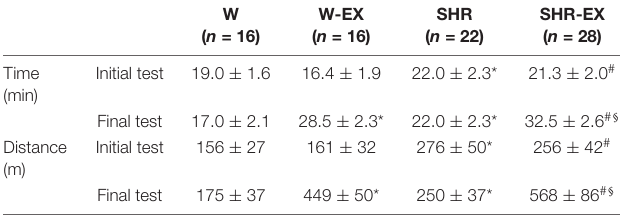
Frontiers in Physiology |